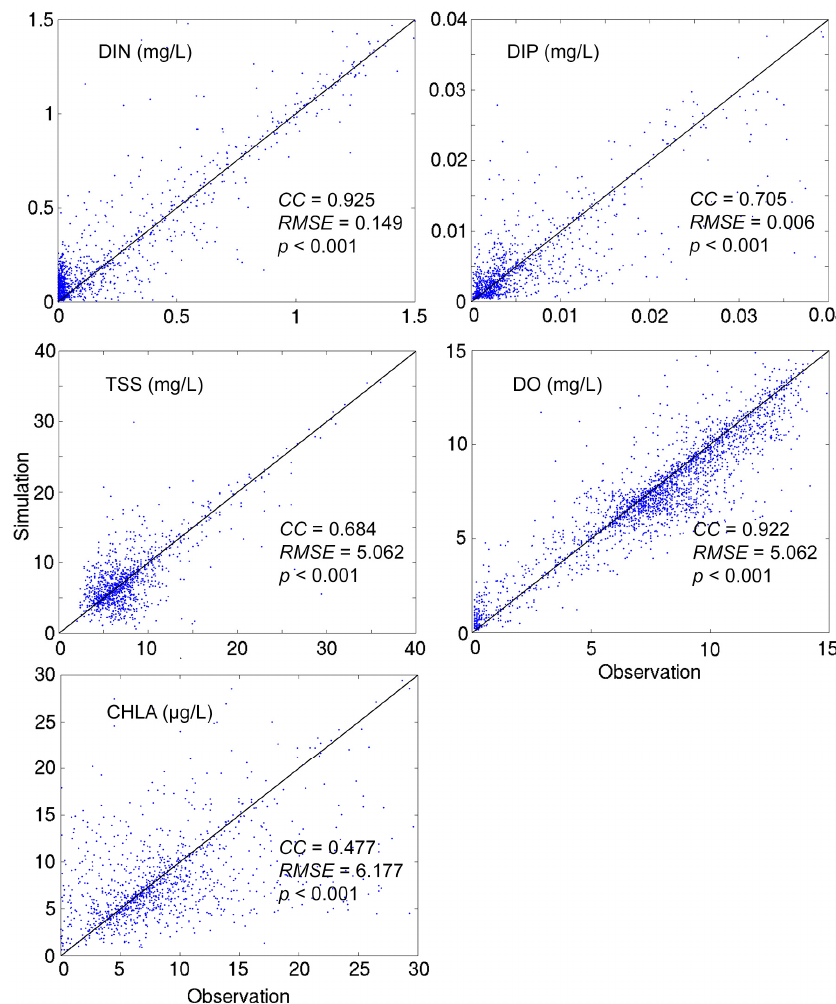
Figure 13. Comparison between modeled and observed dissolved inorganic nitrogen (DIN) and phosphorus (DIP), dissolved oxygen (DO), total suspended solids (TSS) and chlorophyll-a (CHLA) from 2003–2012. CC and p denote the correlation coefficient and its p -value, and RMSE is the root mean squared error.